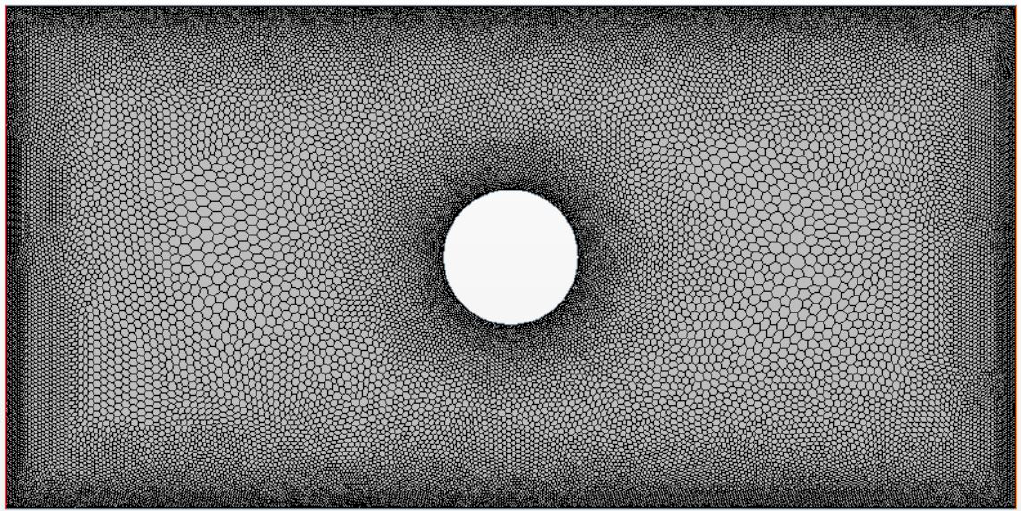
Figure 2. Mesh for a circle-shaped geometry. Table 2. Mesh verification and comparison with experimental data for the case of a cylinder with a = 0.02 m. Mesh Resolution Richardson Extrapolation Coarse